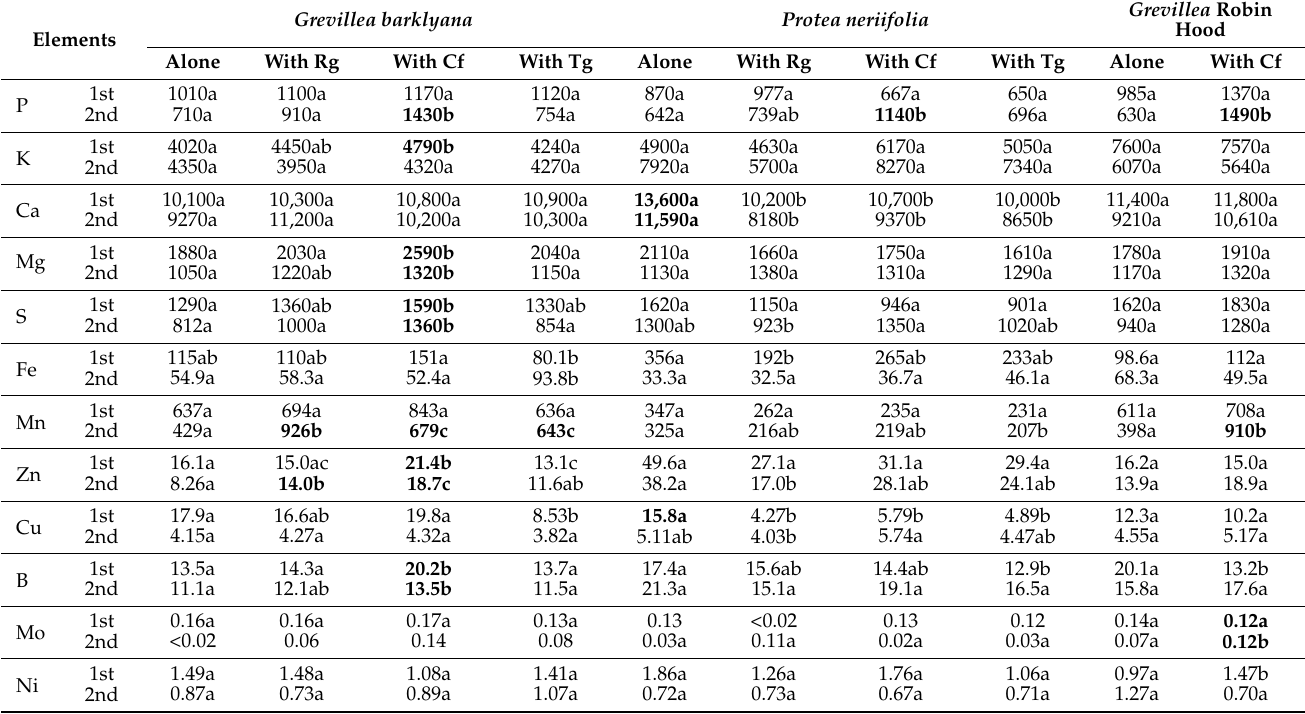
Table A1. Nutrient concentrations in protea foliage while each species was growing with